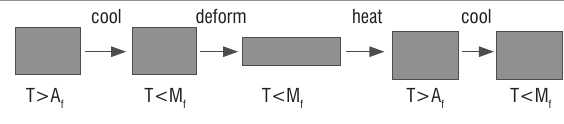
Figure 2: One-way shape-memory effect.